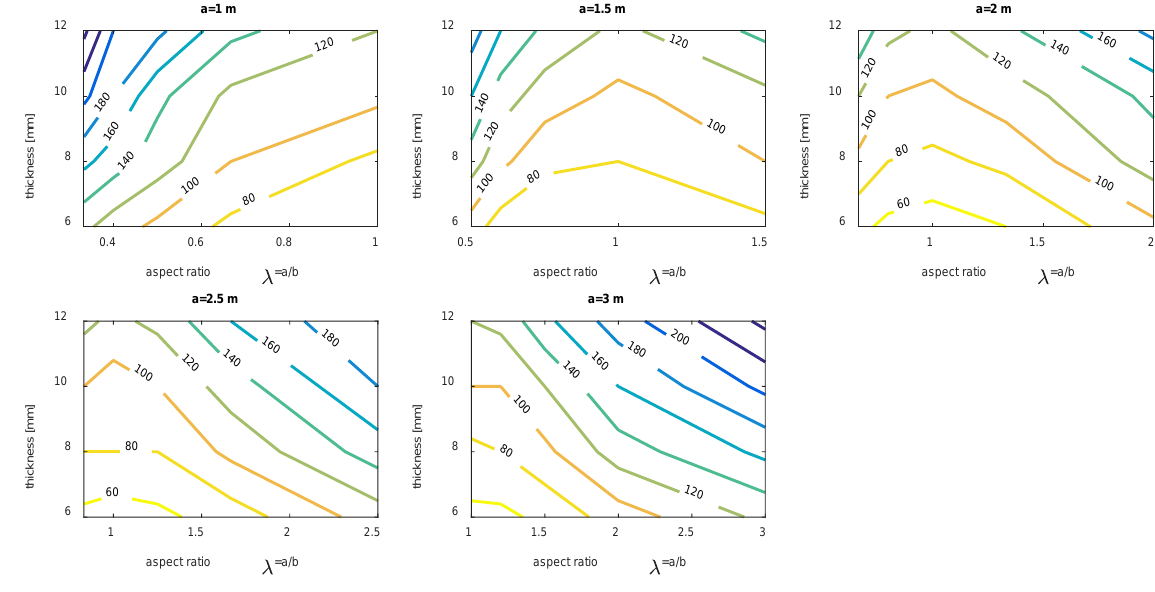
Fig. 7. Plate with rigid edges. Buckling limits for different plate size, aspect ratio and thickness.